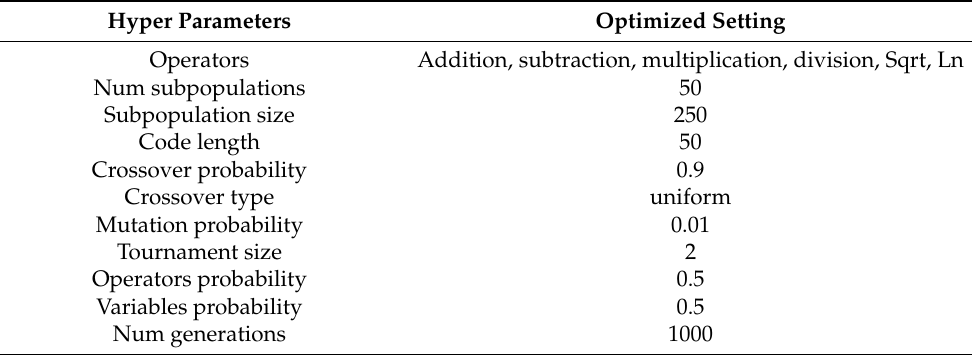
Table 4. The optimized hyper-parameters of MEP model developed for EC and TDS. Hyper Parameters Optimized Setting